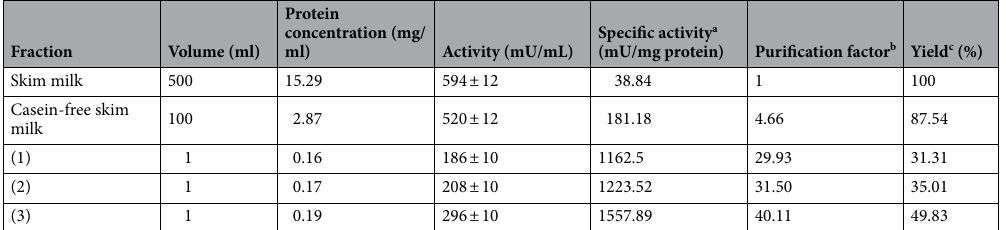
Table 1. Purification of α-amylase from the bovine milk by synthesized magnetic nanocomposites. a Specific activity [mU/mg] = enzyme concentration [mU/mL]/protein concentration [mg/mL], b purification factor for (x) = specific activity of (x)/specific activity of starting material, c yield = total enzyme activity of fraction (x)/ total enzyme activity in starting material.